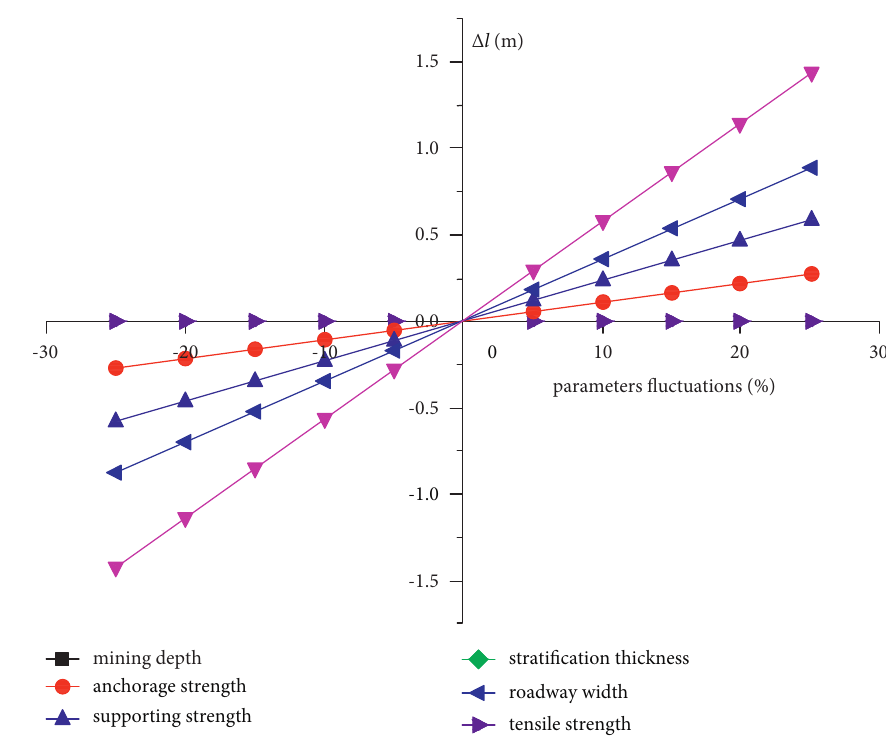
Figure 5: Relationship between the rate of change of each parameter and Δ l .